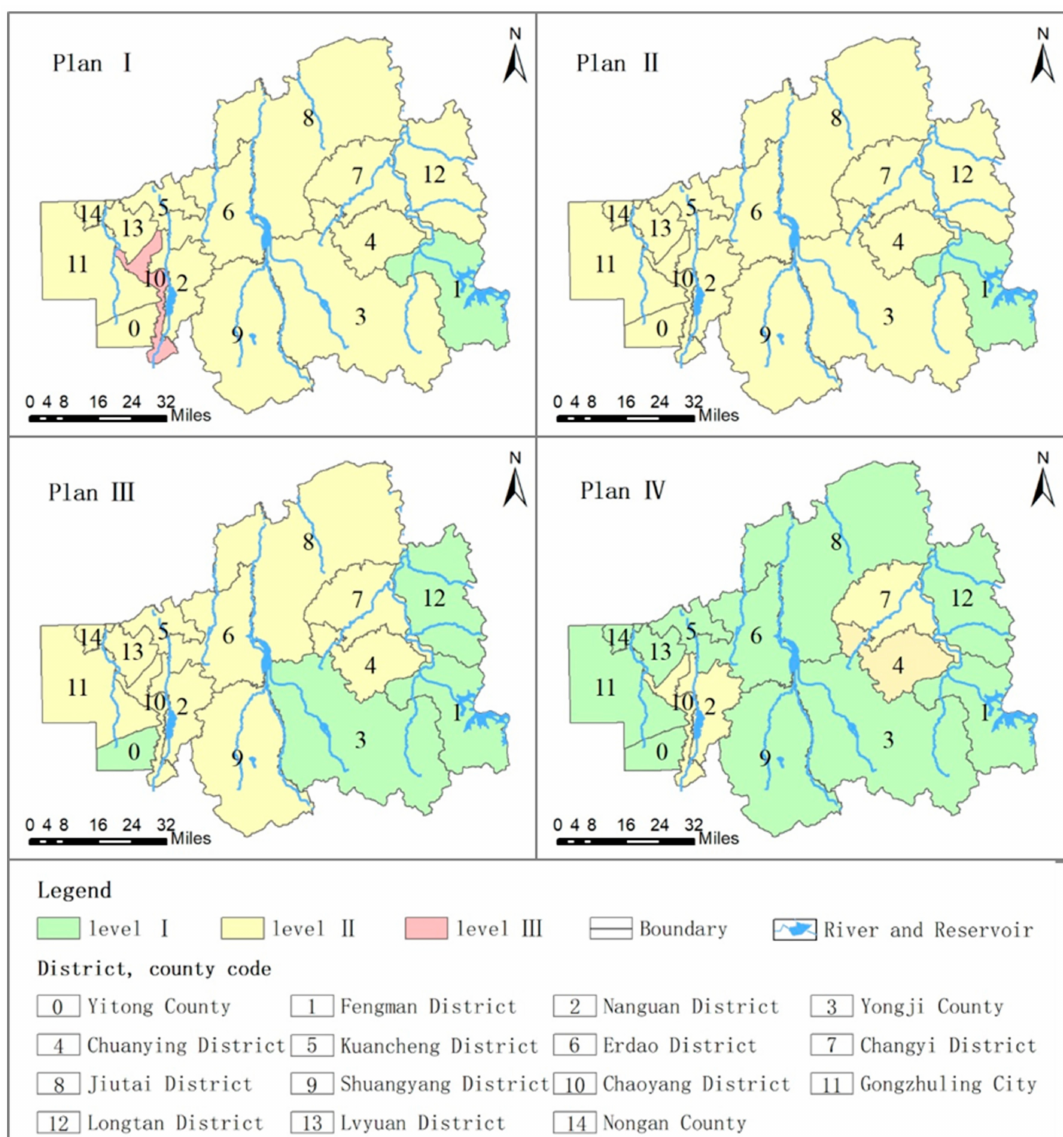
Figure 4. The level division of WRCC evaluation value in each plan